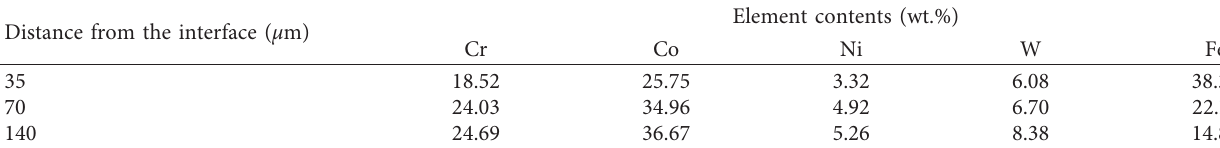
Figure 5: Elements line scanning spectra: (a) A2 coating; (b) B4 coating. Table 8: EDS analysis for Co, Cr, Ni, W, and Fe of B1 coating.